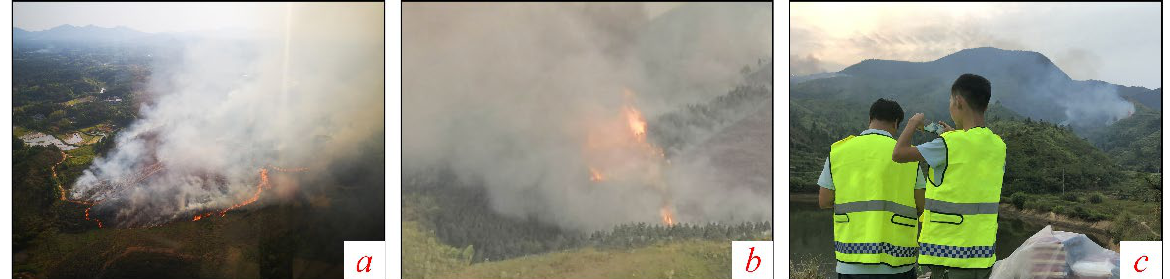
Figure 4. Field measurements to confirm and report forest-fire information. ( a , b ) Forest-fire sites located in Hunan Province, China. ( c ) Well-trained personal confirmed and reported forest-fire in-